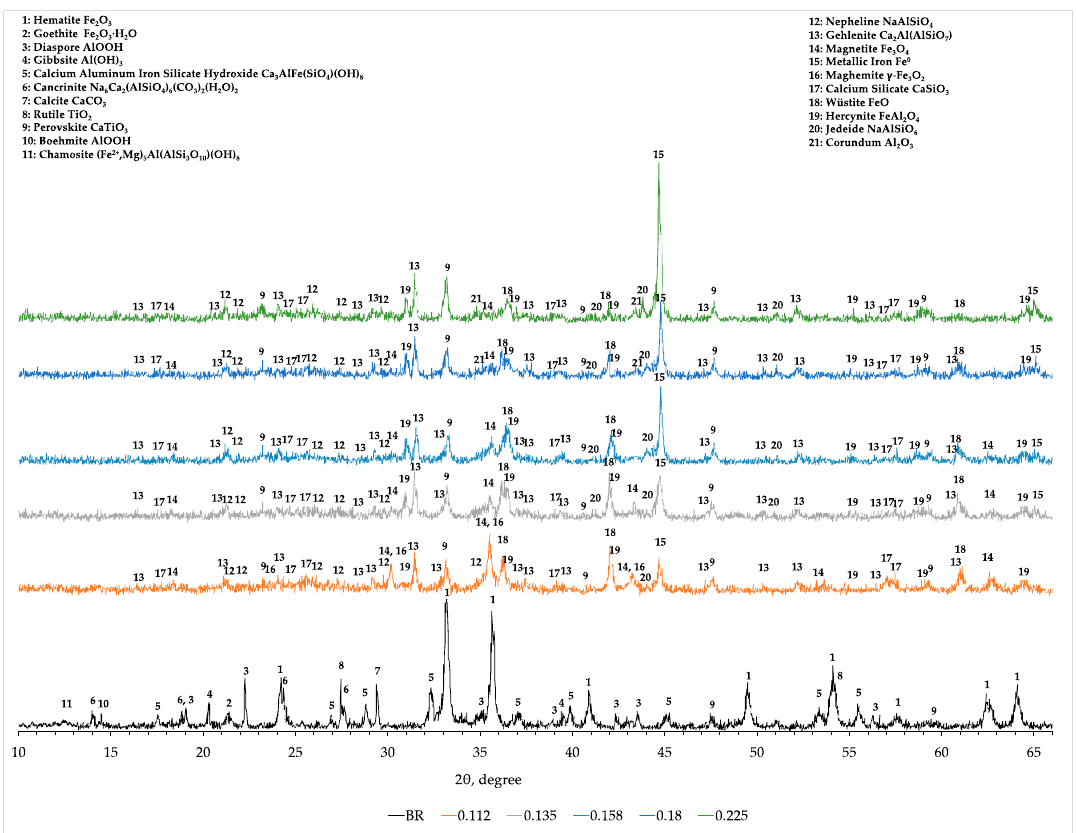
Figure 11. XRD of sinters (300 s, 0.6 kW and 1 L / min N 2 flow) by changing the C / BR ratio between 0.122 and 0.225 compared to XRD of bauxite